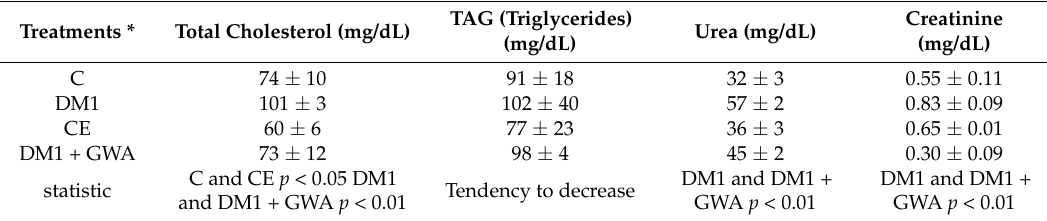
Table 3. Measurements of islets of Langerhans from rats submitted to